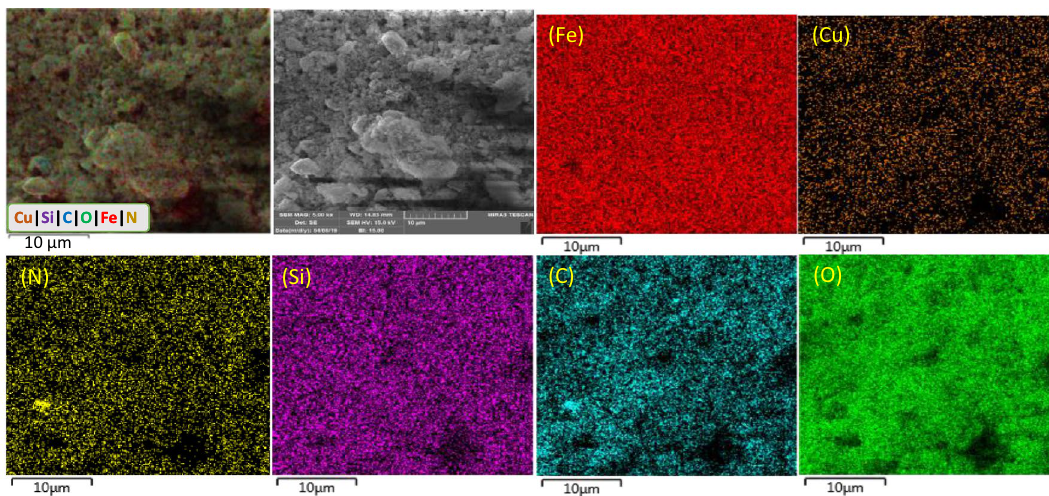
Figure 9. EDS elemental mappings of the γ-Fe 2 O 3 @PEG@PAMAM G 0 -Cu